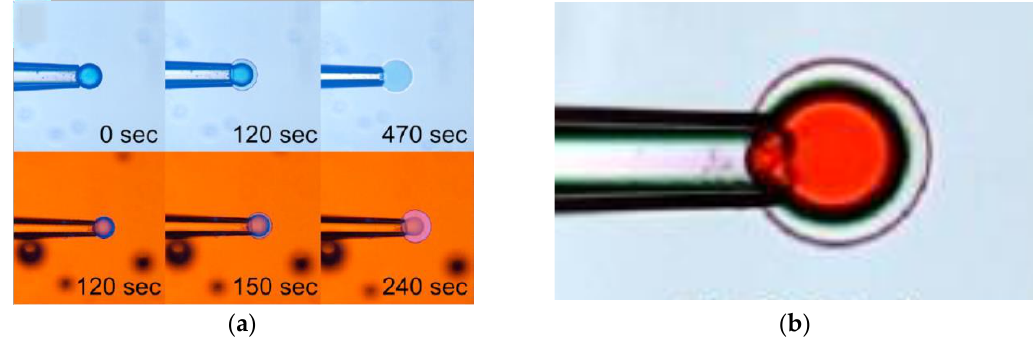
Figure 24. ( a ) Images of DC bead microgels during release of amitriptyline hydrochloride in 150 mM NaCl as observed by light microscopy (upper panel) and fluorescence microscopy (lower panel); ( b ) light microscopy image of DC bead during release of doxorubicin hydrochloride (red color). Acknowledgment: [109].